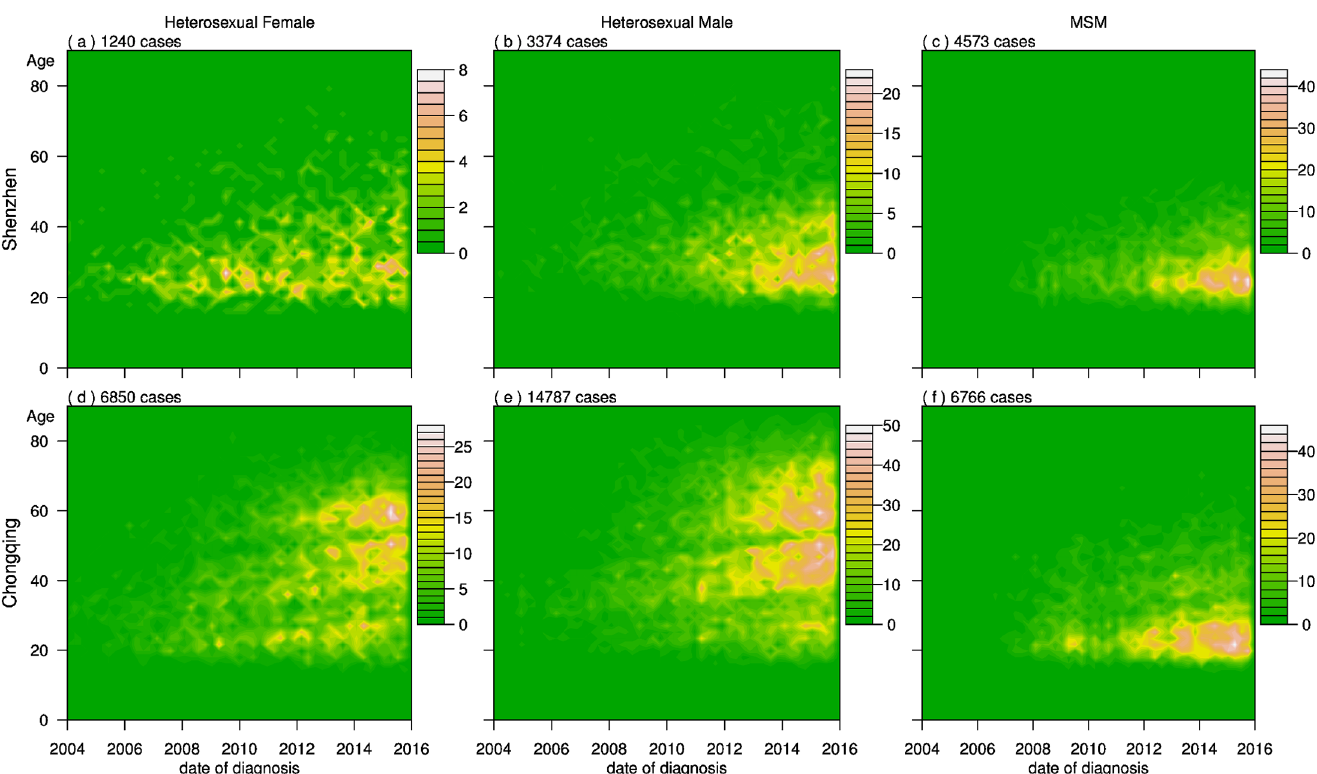
Fig 4. Number of cases by age at diagnosis for different routes of transmission in Chongqing and Shenzhen from their first reported cases to 2015. Within each panel, the vertical axis represents ages from 0 to 80, while the horizontal axis corresponds to the year of the analysis from 2004 to 2015. The standardized ratio of new HIV diagnoses per 100,000 population is represented by different colors, as depicted by their color codes. The heterosexual cases in Chongqing appear to be split by two strips, which is most likely due to the low birth rates during the early 1960’s and 1980’s.